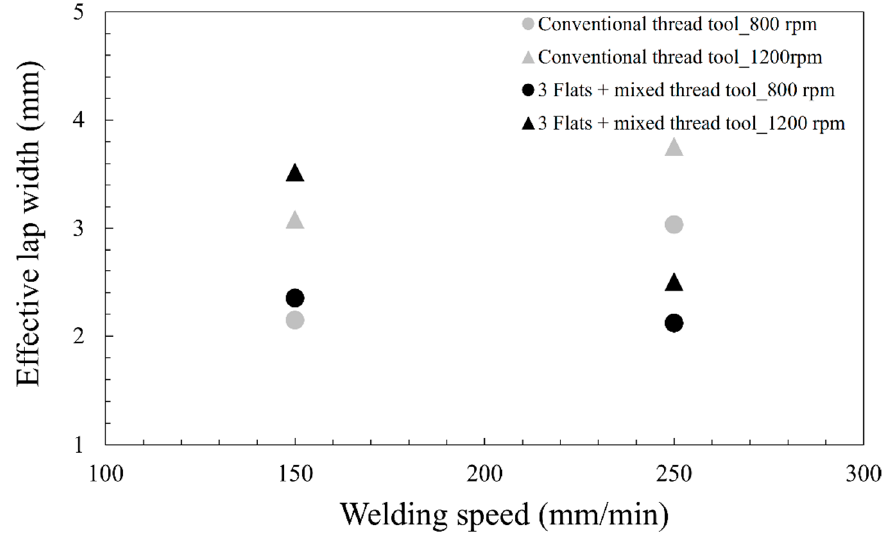
Figure 7. Effective lap width (ELW on Figure 3a) as a function of welding speed for the studied tool geometries and rotational speeds.